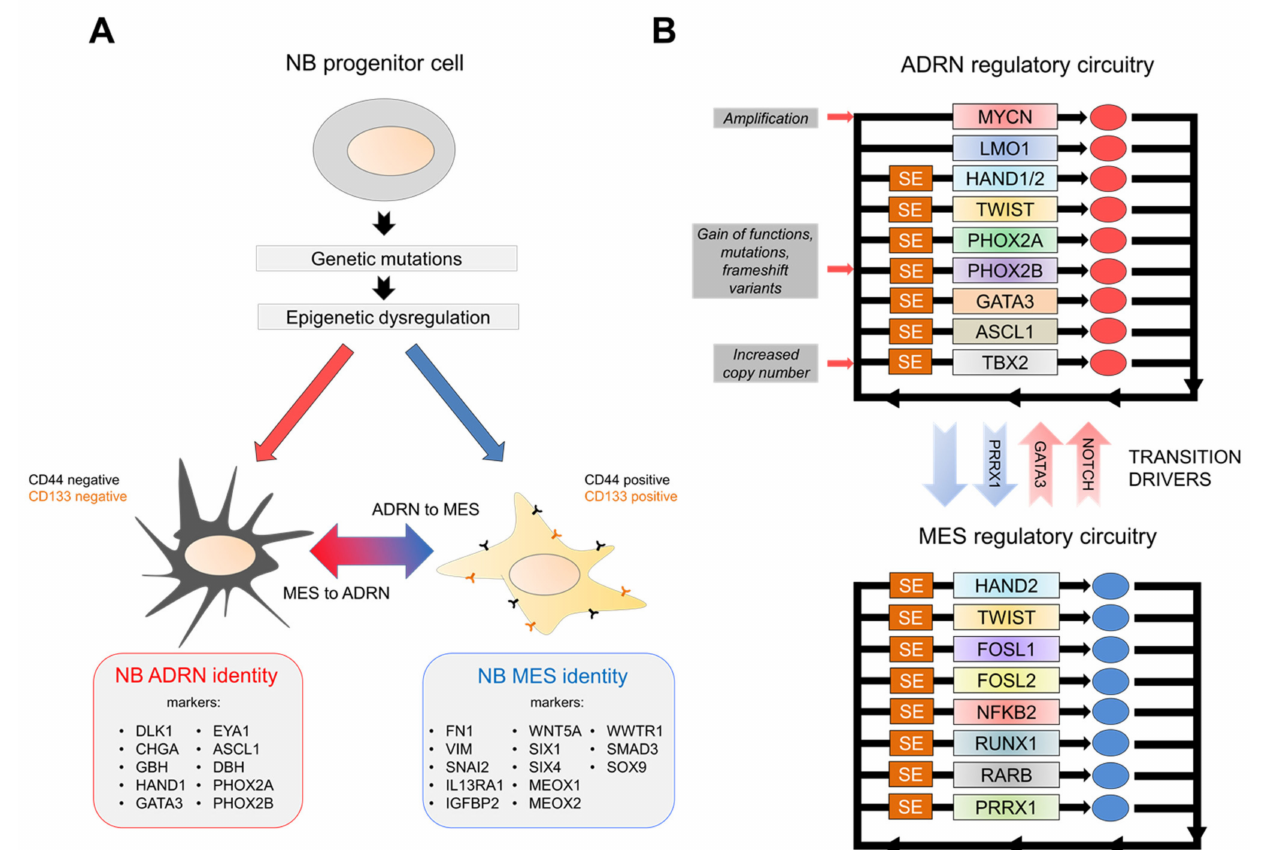
Figure 1. ( A )Transition between mesenchymal (MES) and adrenergic (ADRN) neuroblastoma states depends on specific core regulatory circuitries. ( B ) Convergence of genetic mutations and epigenetic alterations results in oncogenic signalling dysregulation depending on feed-forward core transcriptional circuitries in human NBs. CRCs result in interconnected and autoregulated networks among TFs, which can drive the development of specific subtypes of NBs by establishing distinct gene expression signatures. “SE” refers to “Super